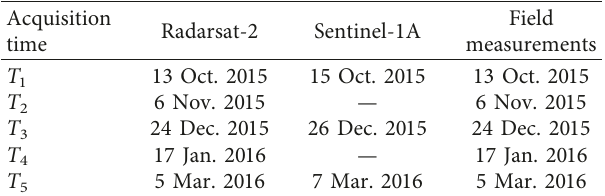
Table 2: Time of SAR data acquisitions and field measurements.